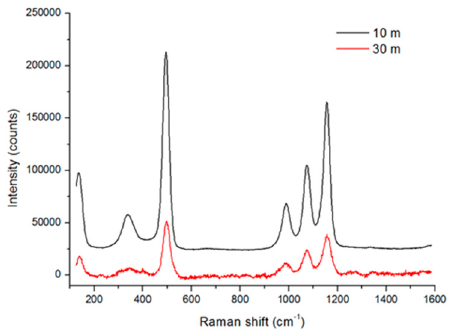
Figure 9. Raman spectrum from Teflon acquired at a target distance of 10 m (black line) and 30 m (red line) by accumulating the signal over 50 laser shots with the energy of 16 mJ.